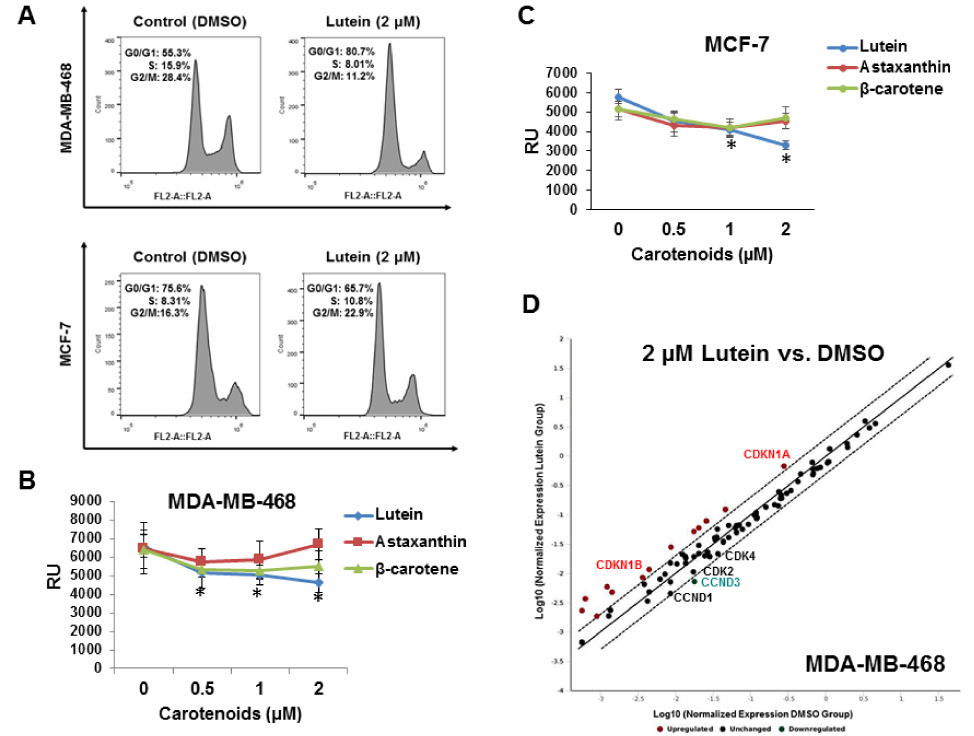
Figure 2. Effect of lutein on cell cycle distribution in triple-negative MDA-MB-468 cells. ( A ) Lutein induced G1 cell cycle arrest in MDA-MB-468 cells and G2 arrest in MCF-7 cells. MDA-MB-468 and MCF-7 cells were treated with 2 µ M lutein for 48 h. 0.1% DMSO vehicle was used as control. The distribution of cell cycle phases was assessed by flow cytometry. ( B ) and ( C ) EdU proliferation assays were performed in MDA-MB-468 and MCF-7 cells. Breast cancer cells were grown in 96-well plates and treated with carotenoids (lutein, β -carotene, astaxanthin) at 0.5–2.0 µ M or DMSO for 48 h. Data shown represent mean ± S.D. ( n = 6); * p < 0.05. ( D ) The scatter plot compares the normalized expression of every gene on the array between the two groups (lutein vs. DMSO) by plotting them against one another to quickly visualize large gene expression changes. The central line indicates unchanged gene expression. The dotted lines indicate the 2-fold regulation